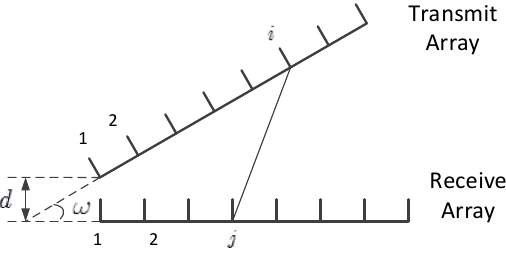
Figure 2. The transmit and receive antenna arrays of a